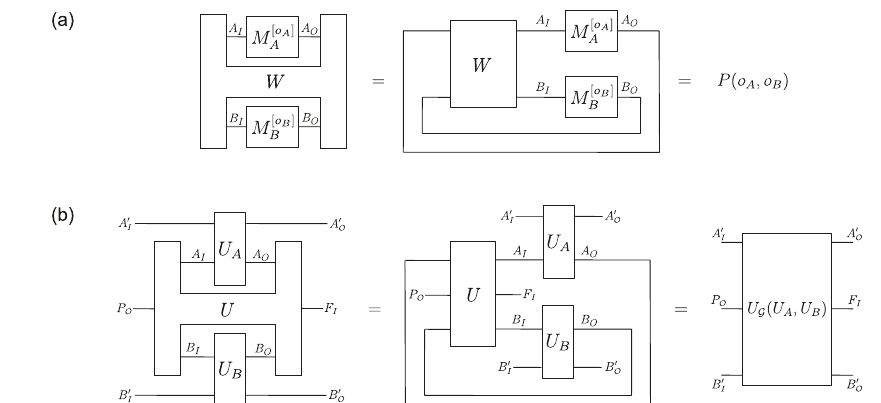
b Composing a unitarily extended process matrix with unitary operations per- formedbythepartiesgivesrisetoaunitaryoperationfromtheoutgoingsystem P O of the global past party P and the incoming ancillas of the parties A 0 I , B 0 I to the incoming system F I of the global future party F and the outgoing ancillas of the parties A 0 O , B 0 O 34